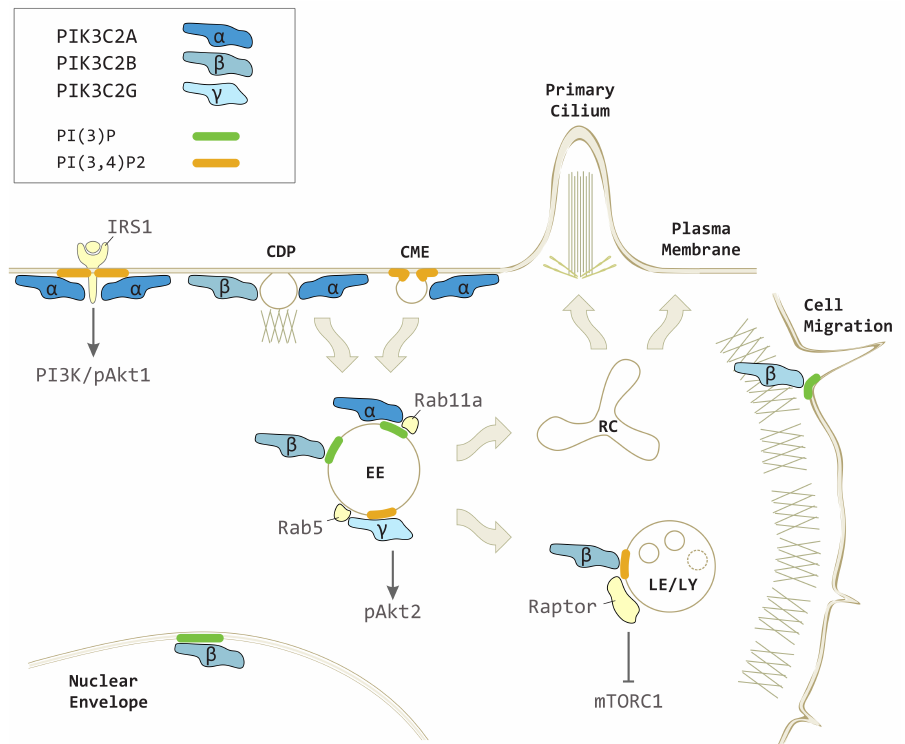
Figure 2. PIK3C2A, PIK3C2B and PIK3C2G in vesicular trafficking and intracellular signaling. PIK3C2A produces localized pools of PI(3,4)P2 on plasma membrane contributing to clathrin-mediated endocytosis (CME) and insulin receptor substrate 1 (IRS1) mediated class I PI3K-dependent phospo-Akt1 (pAkt1) signaling. PIK3C2A generates a pool of PI(3)P on early endosomes (EE) promoting recycling processes toward the recycling compartment (RC) and primary cilium. PIK3C2A and PIK3C2B both participate to clathrin dependent pinocytosis (CDP) on plasma membrane. PIK3C2B produces PI(3,4)P2 on late endosomes/lysosomes (LE/LY) to repress mTORC1 signaling through Raptor. PIK3C2B generates a localized pool of PI(3)P on EE during insulin signaling, on nuclear envelope, and at the leading edge during cell migration. PIK3C2G is recruited on EE by Rab5 to produce PI(3,4)P2 and increases phospho-Akt2 (pAkt2)